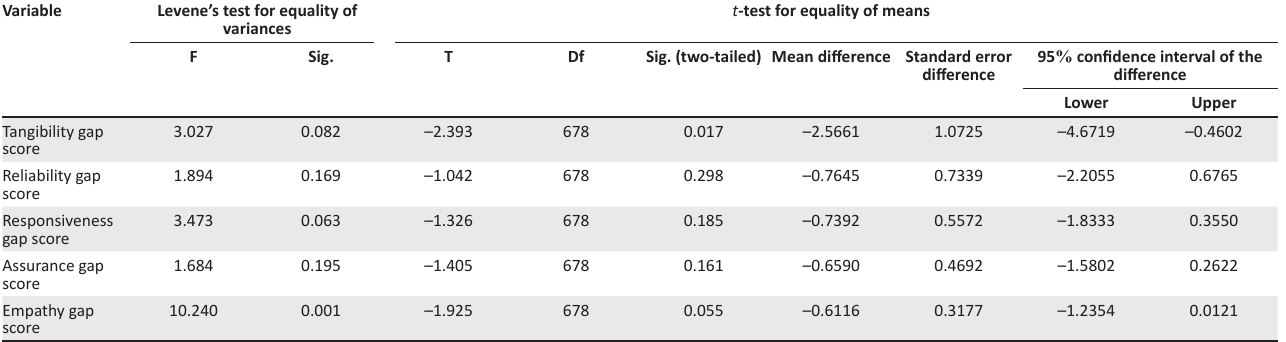
TABLE 6: Levene’s test for Equality of Variances and loyalty programme. Variable Levene’s test for equality of